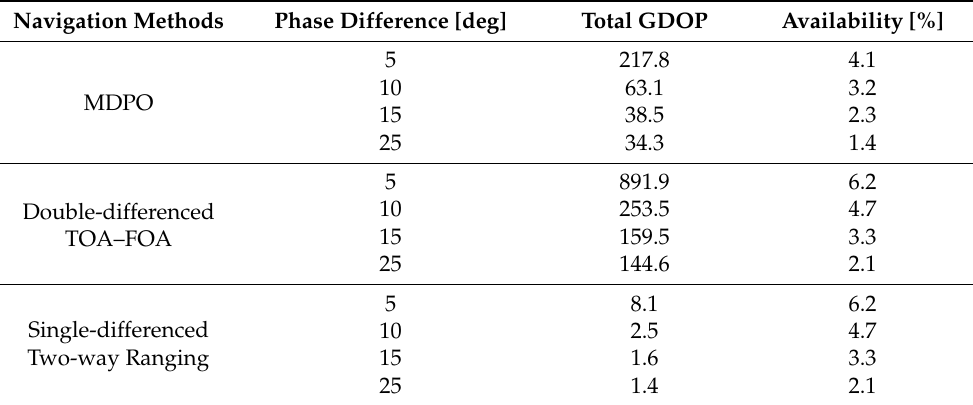
Table 2. The Total GDOP and availability comparison among three navigation methods under different orbital conditions: two satellites are placed in 300 km circular low lunar orbit with different phase differences (5, 10, 15, and 25 deg). The rover/lander position were fixed to the south pole ( − 90 deg latitude), and the satellite orbit inclination was fixed to 110 deg.